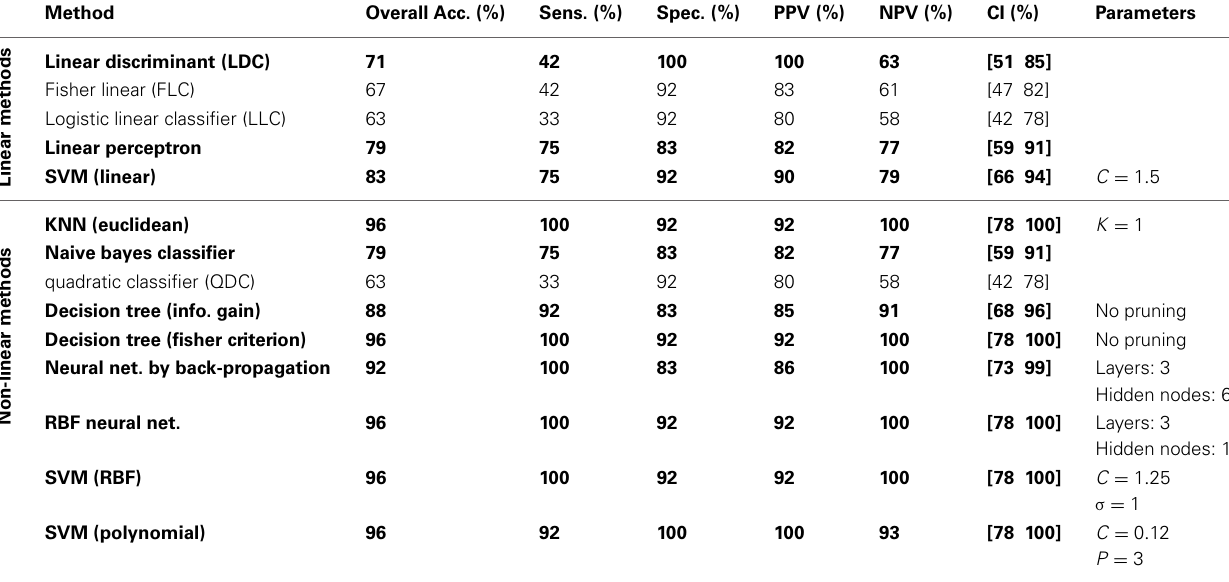
Overall Acc, overall accuracy; Sens, sensitivity; Spec, Specificity; PPV, positive predictive value; NPV, negative predictive value; CI, Wilson’s binomial confidence interval. Bold classifiers perform above the chance (lower bound of confidence interval is greater than 50%).